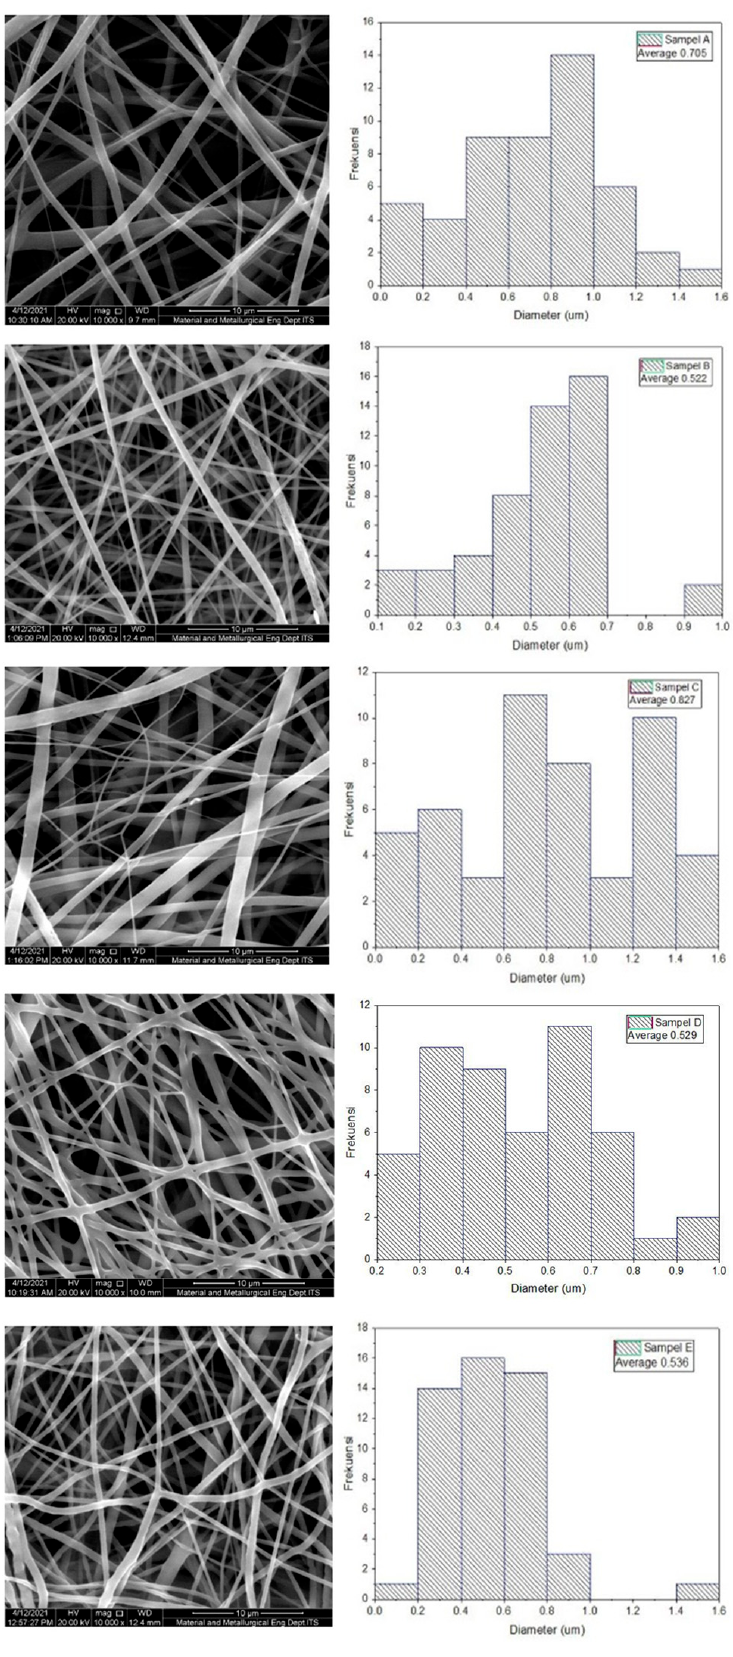
Figure 3. SEM observation results and fiber diameter distribution of the samples with a composition of PLA:PCL; A (100:0), B (85:15), C (80:20), D (70:30), and E (0:100) in